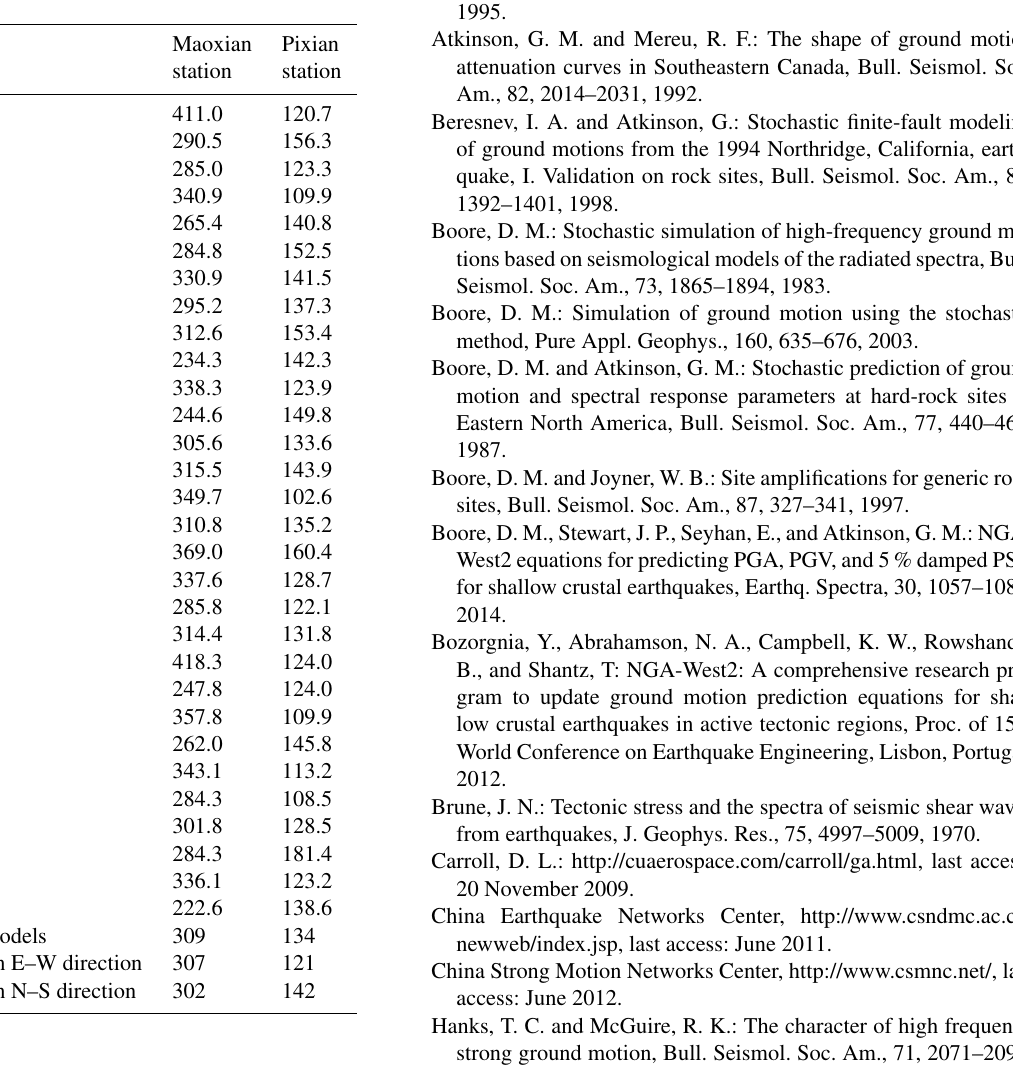
Table 3. Synthesized PGA and observed PGA at two rock stations